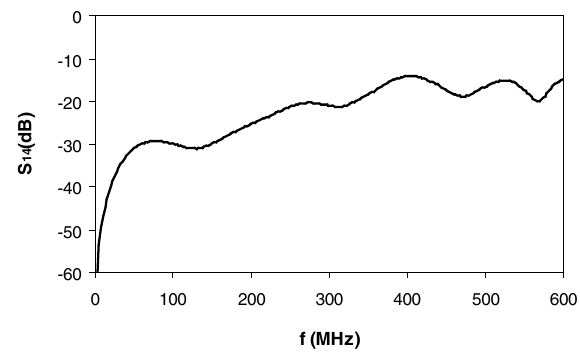
FIG. 19. S measurement for the manufactured coupler in 14 the relevant frequency